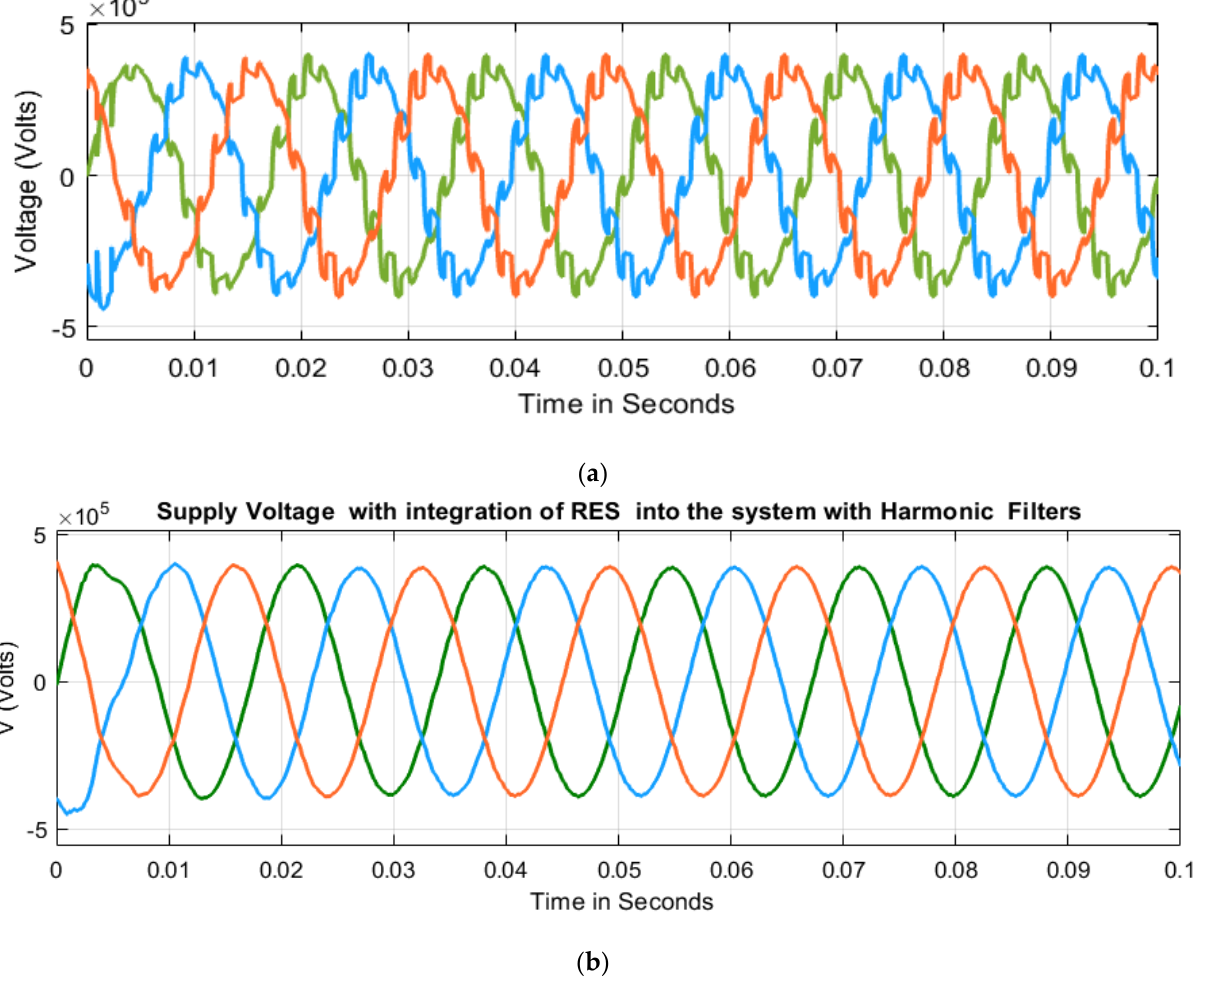
Figure 16. ( a ) Supply voltage after integration of PV source into the system without harmonic filters. ( b ) Supply voltage after integration of PV source into the system with harmonic filters.